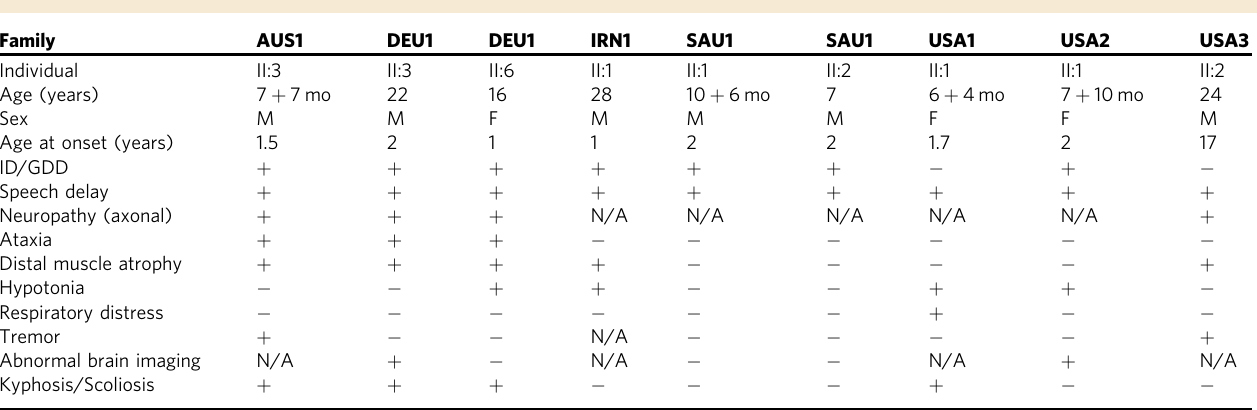
Table 1 Clinical features of affected